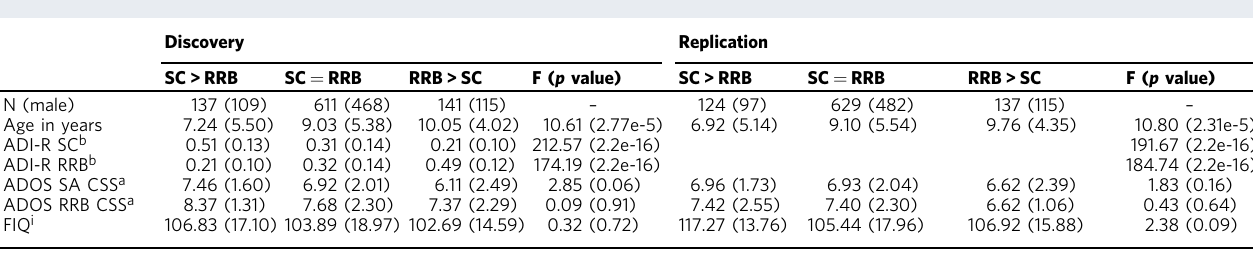
Table 1 Participant characteristics from the NDAR